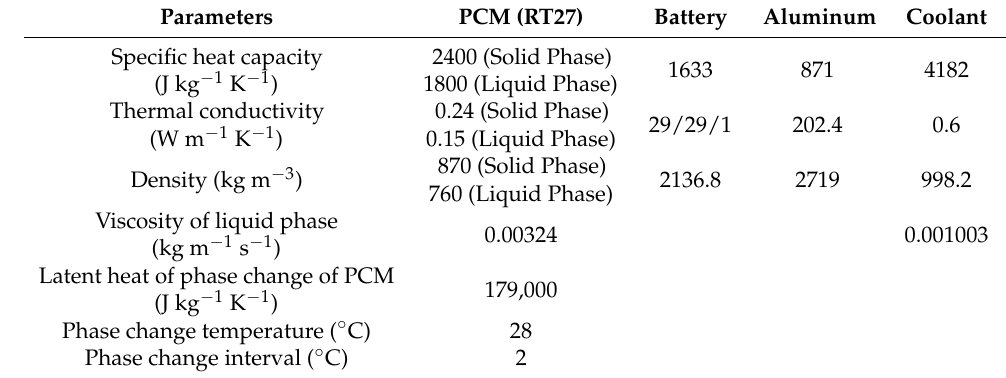
Table 1. Model parameters